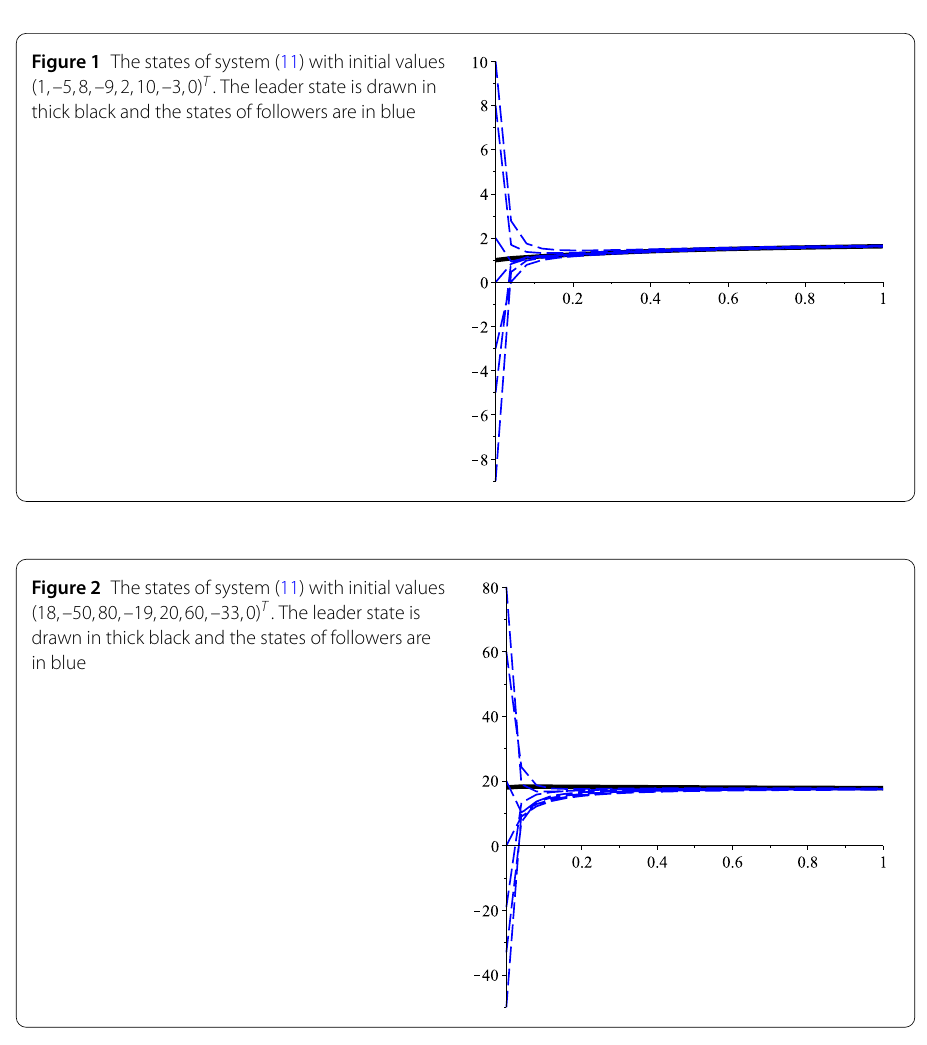
Figure 1 The states of system (11) with initial values (1,–5,8,–9,2,10,–3,0) T . The leader state is drawn in thick black and the states of followers are in blue